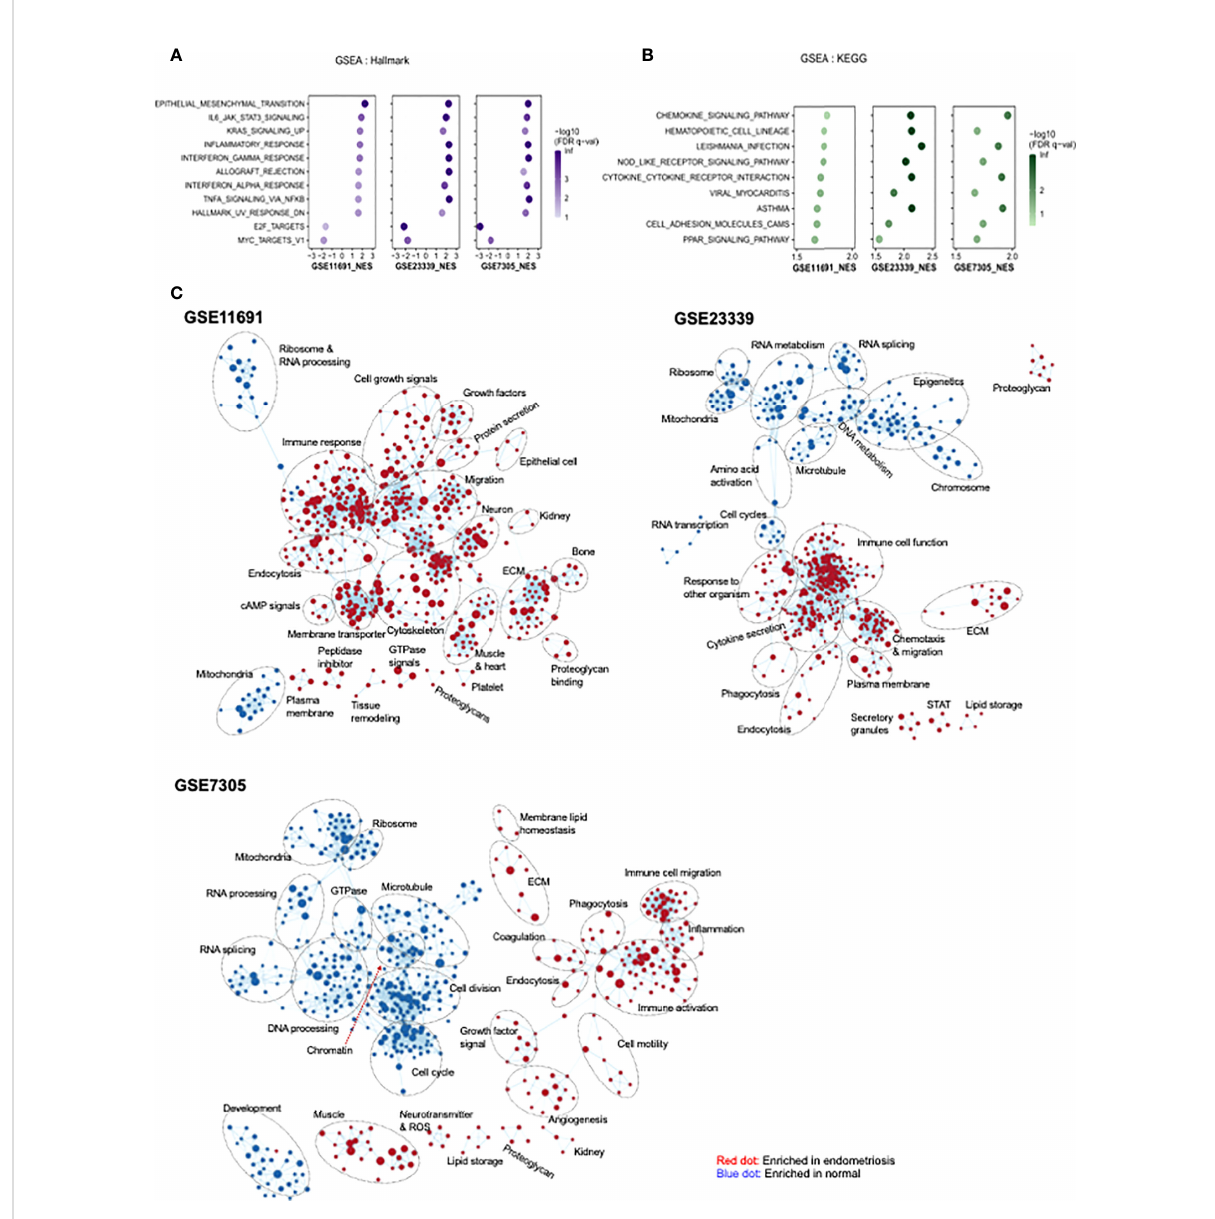
FIGURE 4 Identi fi cation of pathway networks by GSEA. (A, B) Common pathway categories identi fi ed by GSEA with gene set database of Hallmark (A) and KEGG (B) are presented. (C) GSEA was performed to obtain enriched GO-terms and visualized using Enrichment Map plugin of Cytoscape. The size of each node indicates the size of gene set. Red and blue indicate the node enriched in endometriosis and normal tissue,